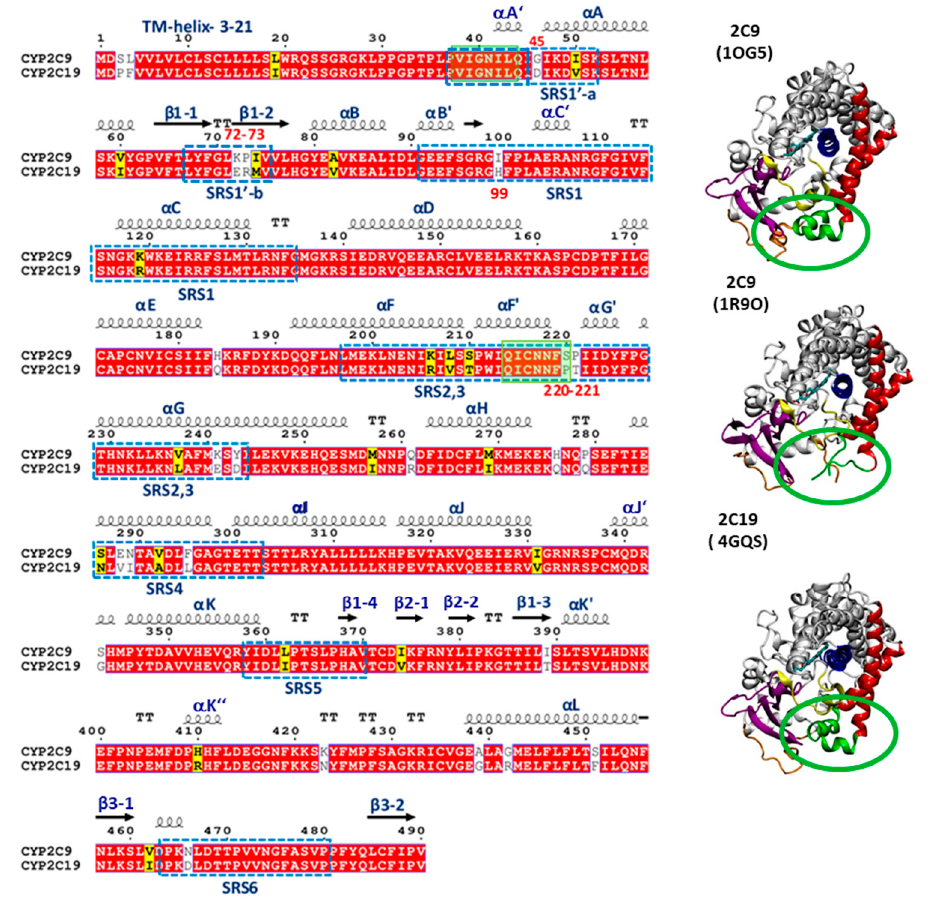
Figure 1. (Left) Sequence alignment of CYP 2C9 and CYP 2C19. Identical residues are shown with a red background, similar residues with a yellow background, and differing residues with a white background. The secondary structure in the crystal structure of CYP 2C19 (PDB 4GQS) is indicated by arrows for β -strands, springs for α -helices, and ‘TT’ for turns; long loops are unmarked. The substrate recognition sites (SRS) are shown by blue dashed line boxes. The residues in the globular domain differing at the membrane interface are highlighted by red numbers. The missing regions in the crystal structure (PDB 1R9O) of the globular domain of CYP 2C9 are shown by transparent green boxes. (Right) Cartoon representations of the crystal structures of CYP 2C9m7 (PDB 1OG5), CYP 2C9 (PDB 1R9O), and CYP 2C19 (PDB 4GQS), showing the structural differences in the F’–G’ region highlighted by the green rings, the heme in stick representation, and key secondary structure elements colored as follows: β -strand regions in magenta, the B–C loop in yellow, the F and G helices in red, the F’–G’ helices/loop in green, the I-helix in blue, and the linker in orange. The active site is lined by the heme and the I-helix.